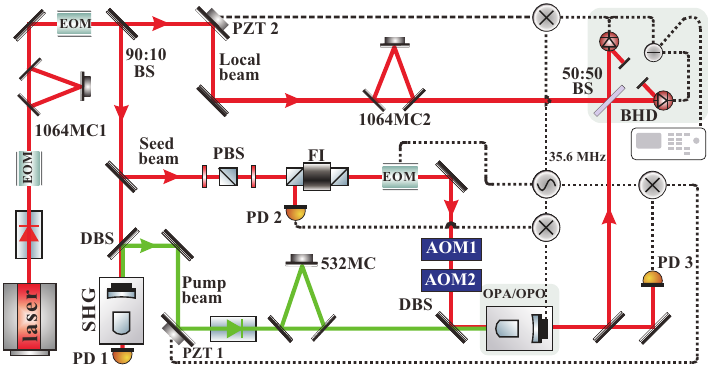
Figure 1. Schematic of the experimental setup. The seed beam was switched on/off by two AOMs manipulated by an FPGA. Laser:single-frequency Nd:YVO 4 laser; EOM, electro-optic modulator; AOM, acousto-optic modulator; FI, Faraday isolator; MC, mode cleaner; SHG, second harmonic generator; OPO, optical parametric oscillator; OPA, optical parametric amplifier; DBS, dichroic beamsplitter; BS, beamsplitter; PBS, polarization beamsplitter; PZT1-2, piezoelectric transducer; PD1-3, photodetector; BHD, balanced homodyne